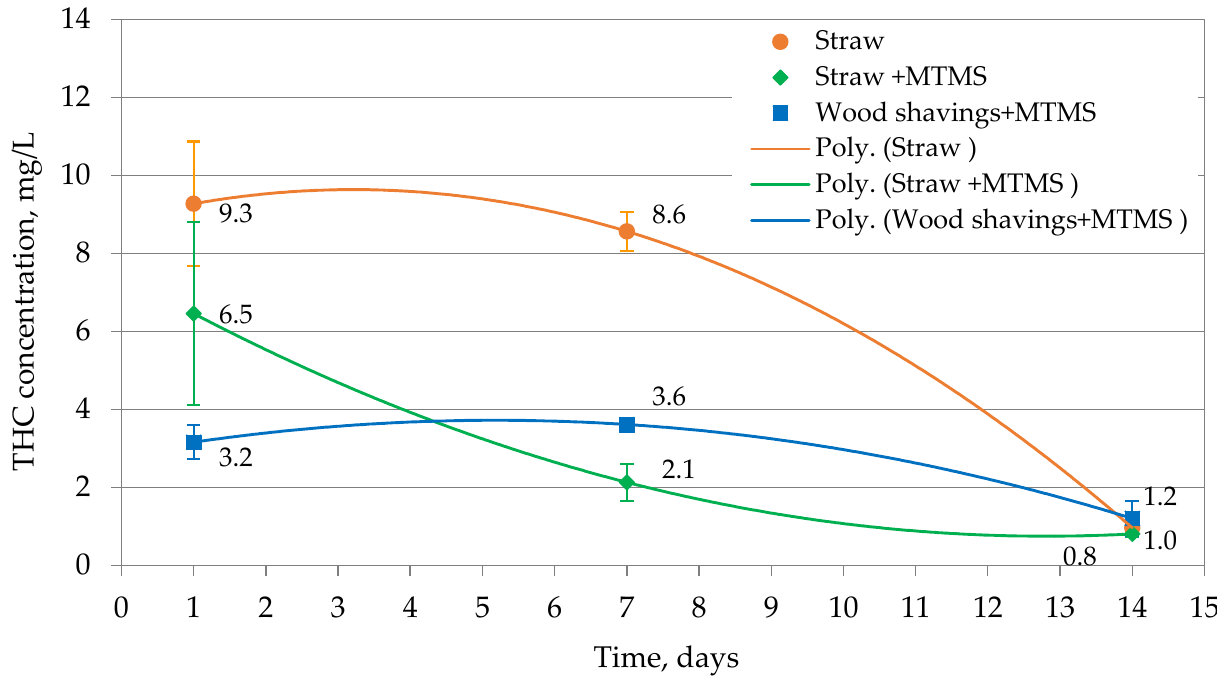
Figure 8. Dynamic of dissolving lubricating oil in sea water. THC concentration of lubricating oil in water in the presence of the sorbents: straw with and without MTMS treatment and MTMS-treated wood shavings after 1, 7 and 14 days.